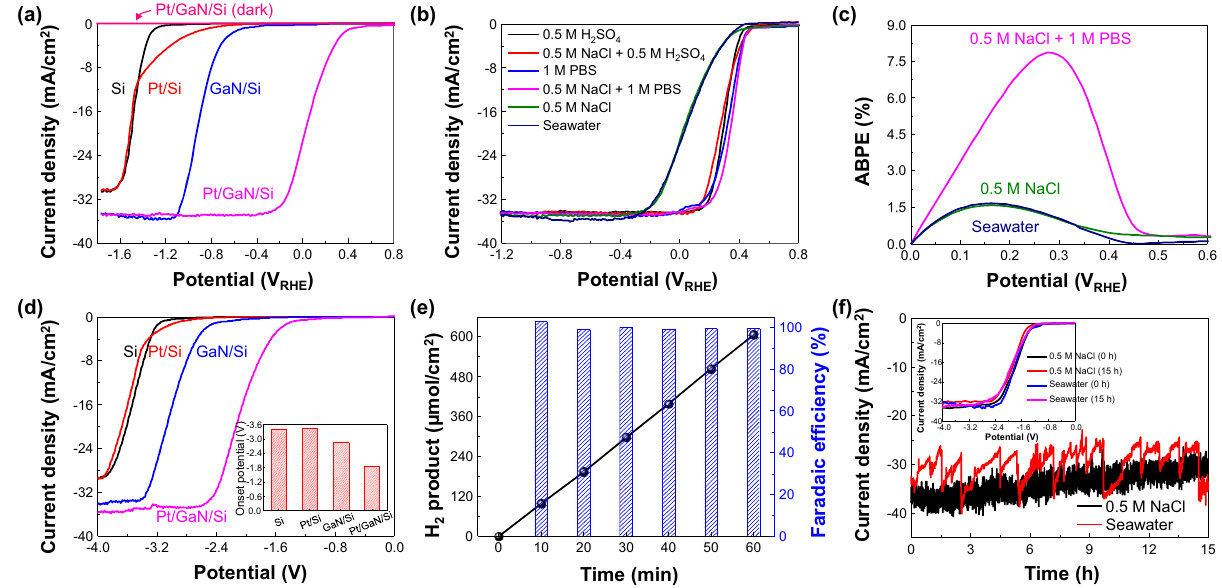
Fig. 2 | Photoelectrochemical seawater hydrogen evolution. a LSV curves of Si, Pt/Si,GaN/Si,andPt/GaN/Simeasuredwith3-electrodecon fi gurationin0.5MNaCl solution under AM 1.5G 1 sun illumination or in dark. b LSV curves of Pt/GaN/Si in six different aqueous solutions. Acidic solutions (pH=0): 0.5M H 2 SO 4 and 0.5M NaCl+0.5MH 2 SO 4 ;Neutralsolutions(pH=7.4):1MPBSand0.5MNaCl+1MPBS; Weakalkaline solution: 0.5M NaCl(pH=9.1)and seawater(pH=8.2). c ABPE of Pt/ GaN/Si in seawater, 0.5M NaCl,and 0.5M NaCl + 1M PBS. d LSV curves of Si, Pt/Si,